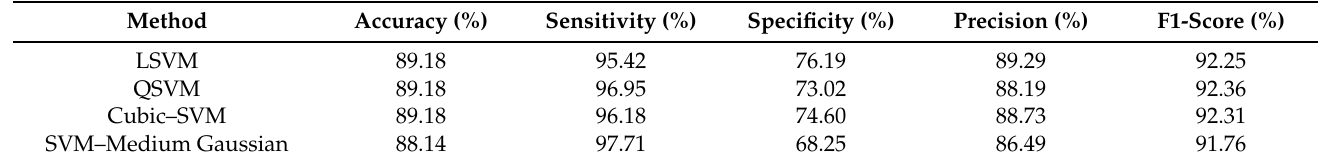
Table 7. CNN activated Feature based classification using 70%-30% split.